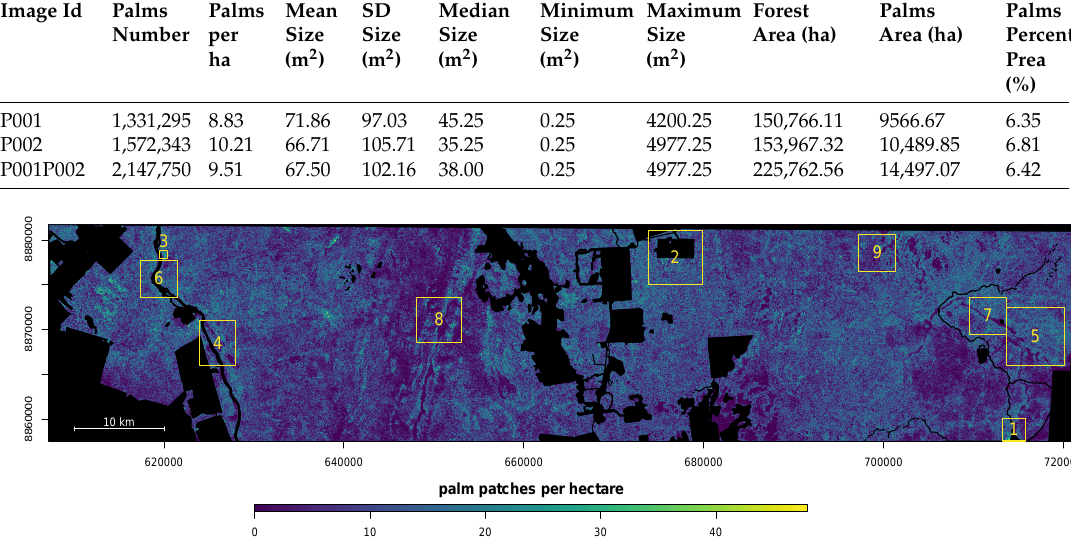
Figure 5. Natural forest fragments and the density of canopy palm trees identified by the U-net network per hectare in the two GeoEye-1 images. One pixel represents one hectare and the color of the pixel represents the canopy palm density, that is the number of palm patches. Rivers, deforestation patches, roads and cloud are masked in black. The yellow boxes show the location of the regions with particular canopy palm distribution which are described in the